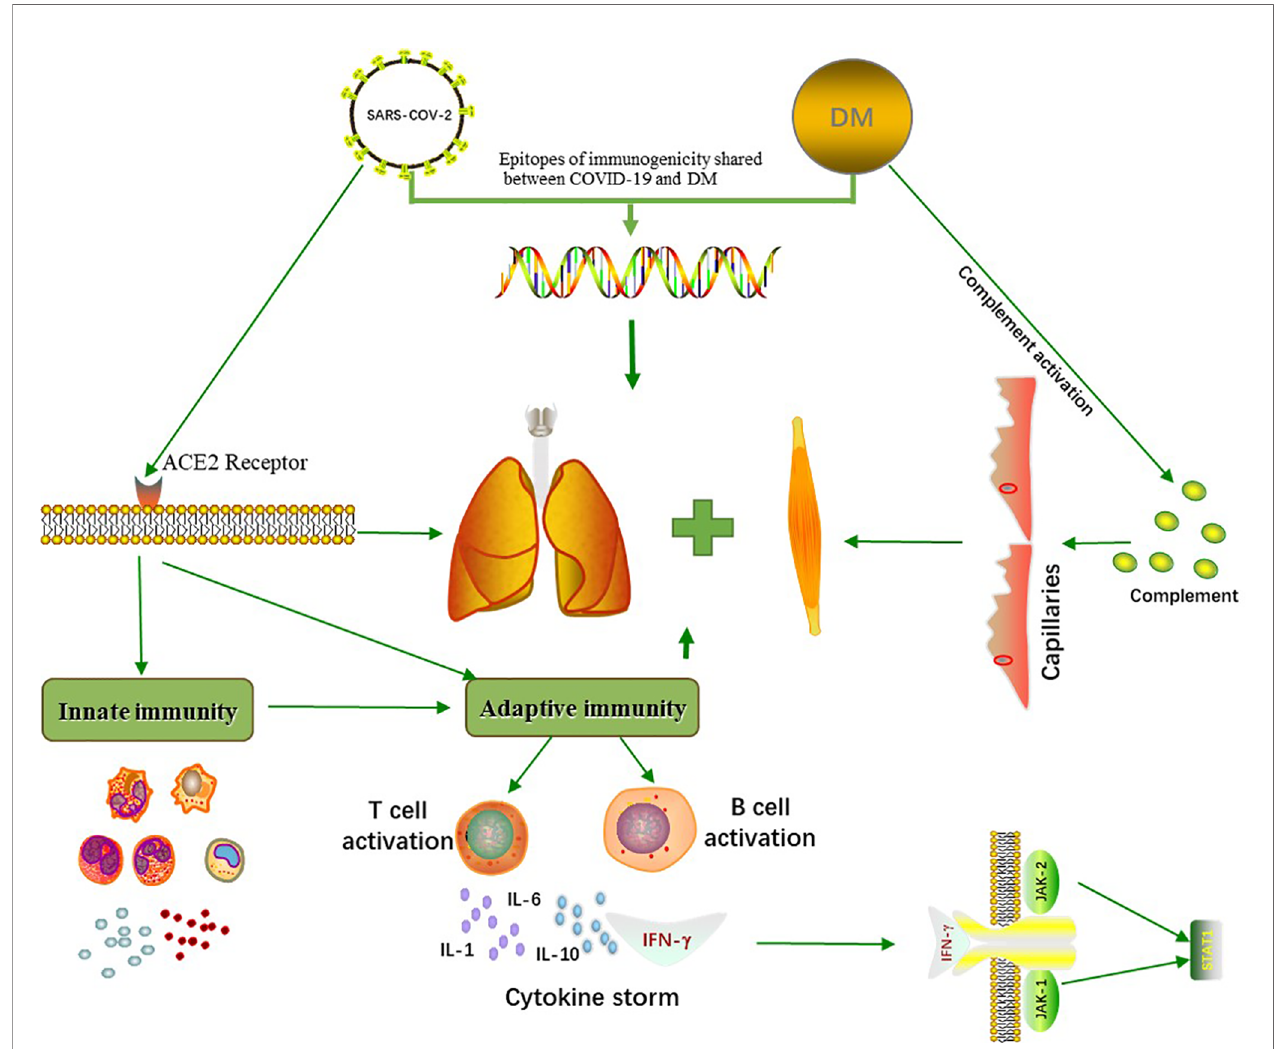
FIGURE 1 | Common pathogenetic mechanisms between COVID-19 and DM. COVID-19 and DM share three immunogenic linear epitopes with high sequence consistency. SARS-CoV-2 enters human cells through the membranous angiotensin-converting enzyme 2 (ACE2) receptors, triggering an innate and adaptive immune response. This initiates the production of cytokines such as IL-1, IL-6, IL-10 and IFN- g , which can induce lung and muscle damage. The activation of complement in DM patients results in capillary destruction, which further affects multiple organs, and cytokine storms are associated with the occurrence of certain subtypes of